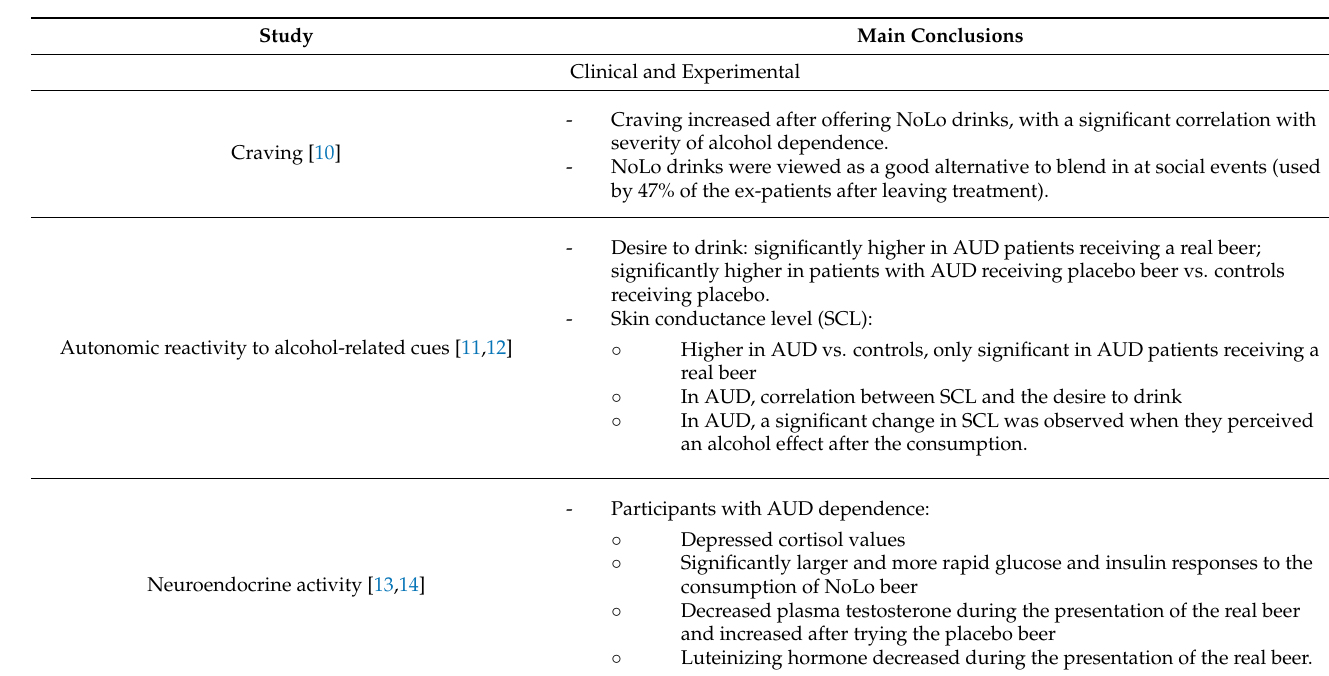
Table 1. Summary of main